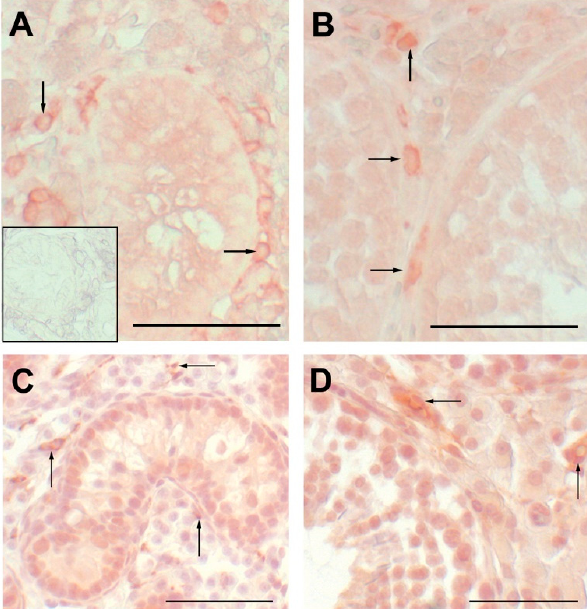
Figure 2. Immunohistochemical labeling of leukocytes (CD45 positive in A , B ) and specifically for macrophages (CD68 positive in C , D ) in the testis. Arrows point to individual leukocytes in testis from a 6.5-week-old boar in ( A ), from a 20-week-old boar in ( B ) and to macrophages in hematoxylin counterstained testis from 6.5-week-old boar in C and from a 20-week-old boar in D. Inset is a normal serum control and is similar to the negatives for the other treatment and age. Scale bar is 50 µ m.